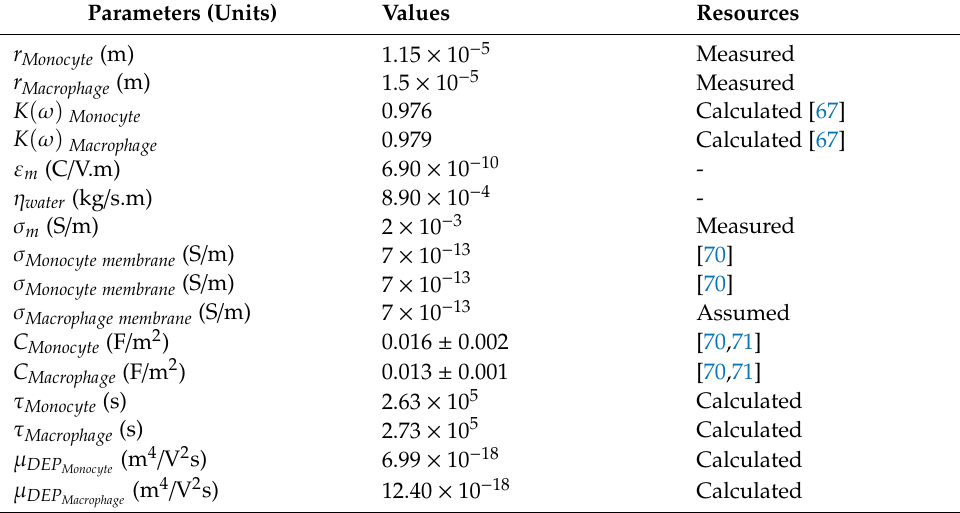
Table 1. Dielectric markers specific to U937 monocytes and U937-di ff erentiated